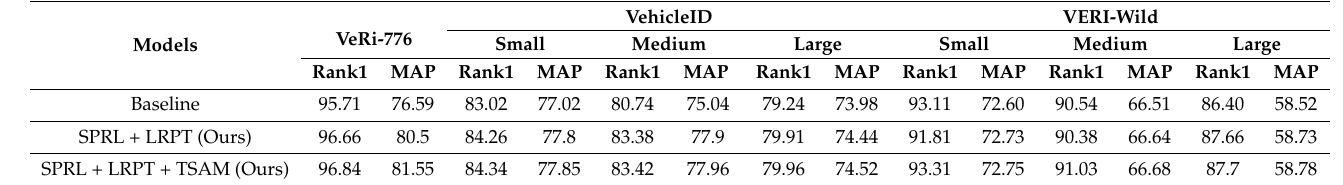
Table 2. Results from the VeRi-776, VehicleID, and VERI-Wild datasets (%).